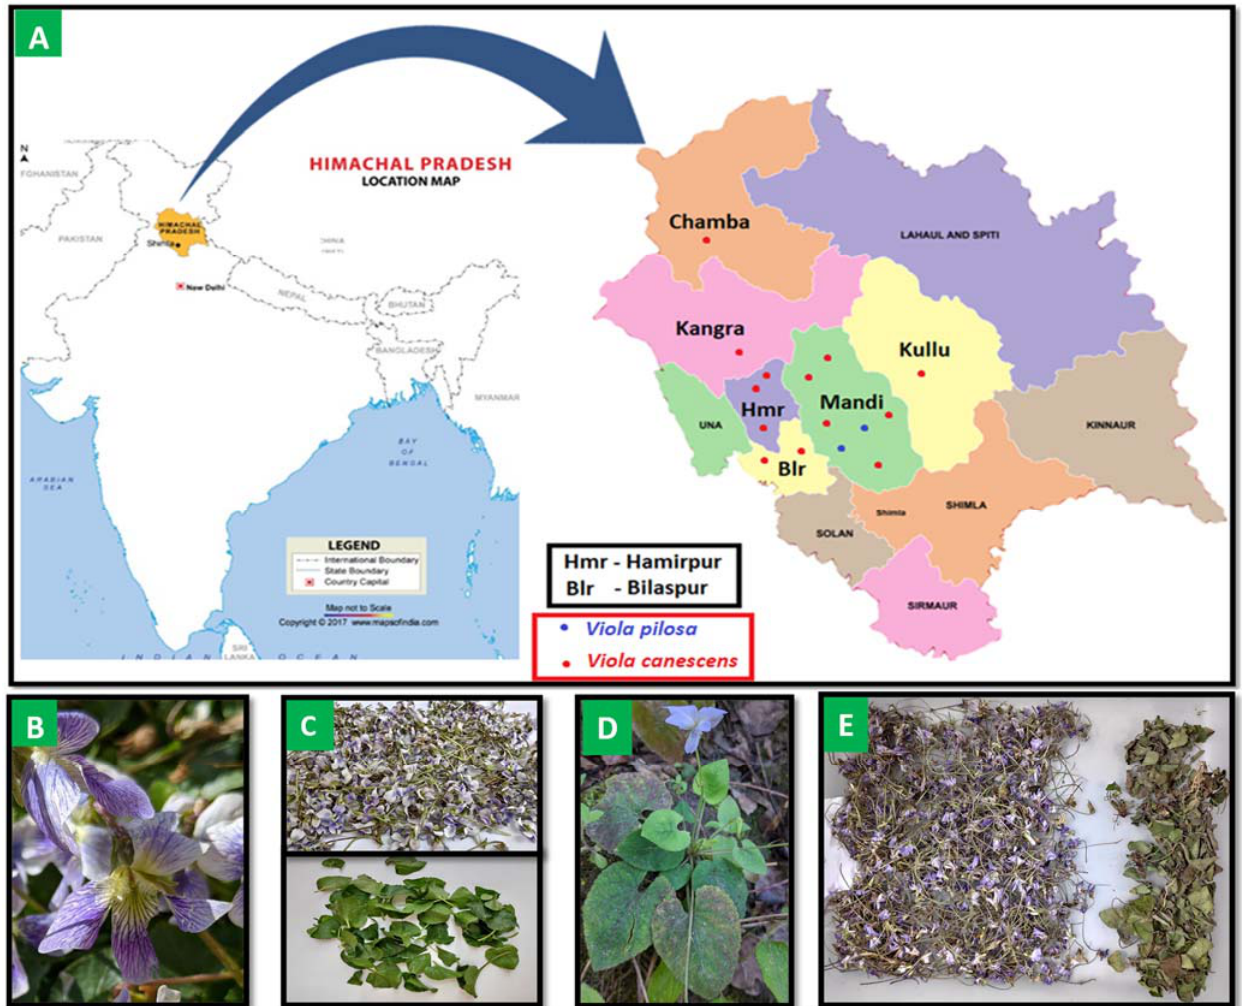
Figure 1. ( A ) Viola species collected from the study area (altitude of 375 to 1829 m) of Himachal Pradesh, India ( B ). V.canescens ( C ). Flowers and leaves of V.canescens ( D ). V. pilosa ( E ). Flowers and leaves of V. pilosa .